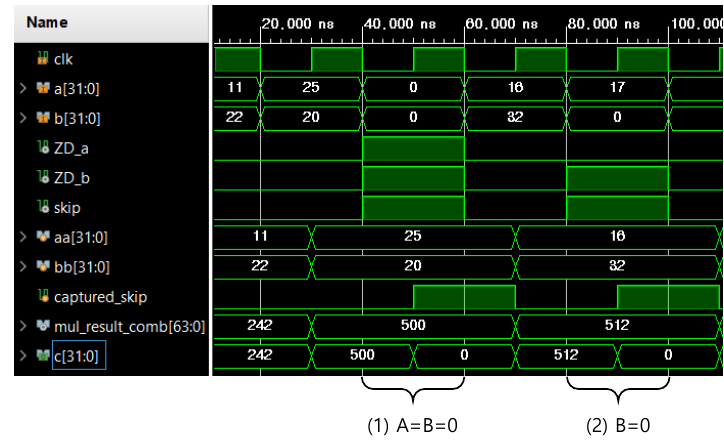
Figure 11. Timing simulation results for the zero-skip